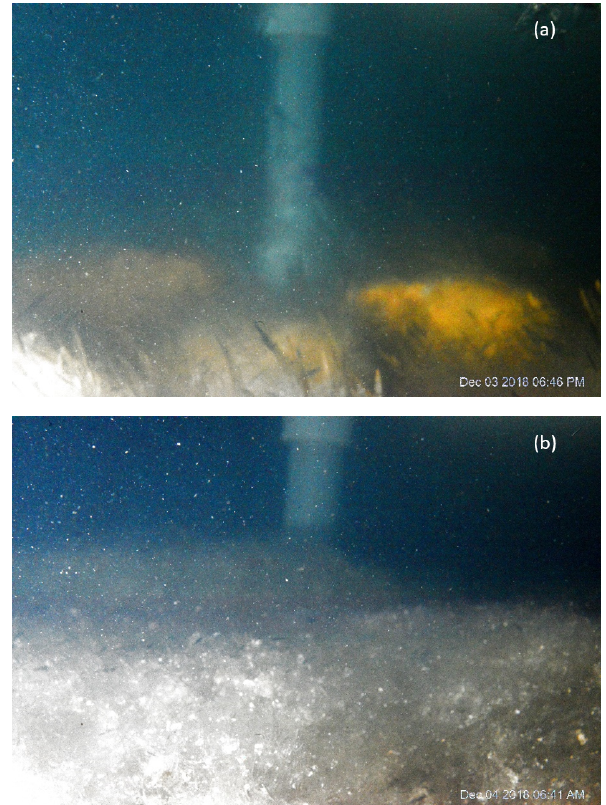
Figure 3. Sample processed images from an anchor ice event on 3 and 4 December 2018 (Event C) showing (a) individual crystals growing off the substrate and (b) anchor ice accumulation over the